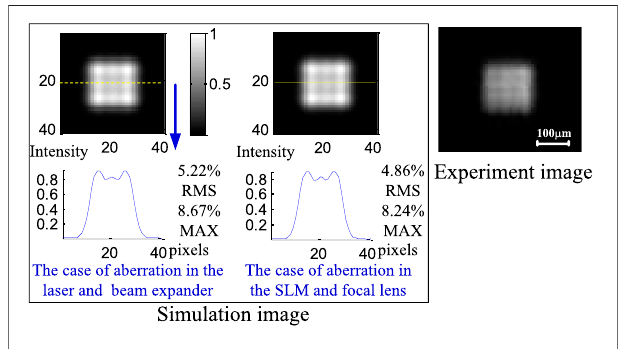
FIGURE 5 | Simulation and experimental results when the defocus aberration is increased to π